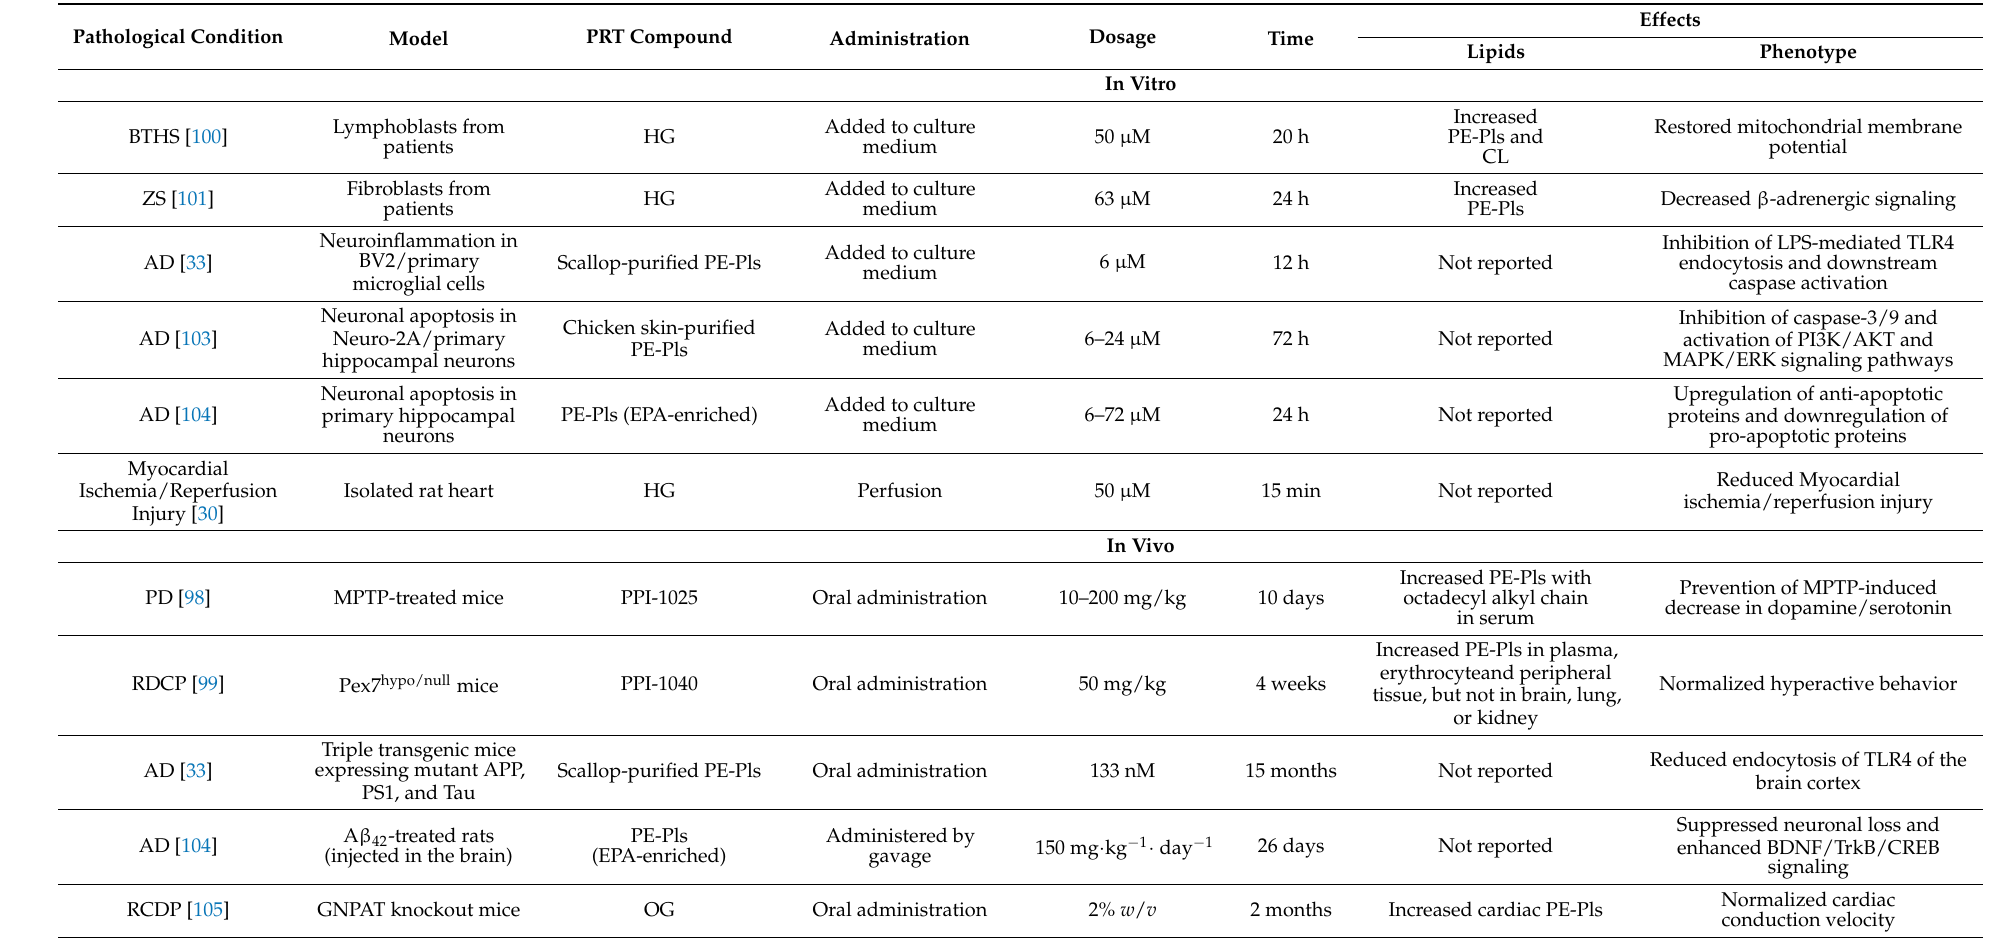
Table 1. Summary of the use of PRT in different clinical